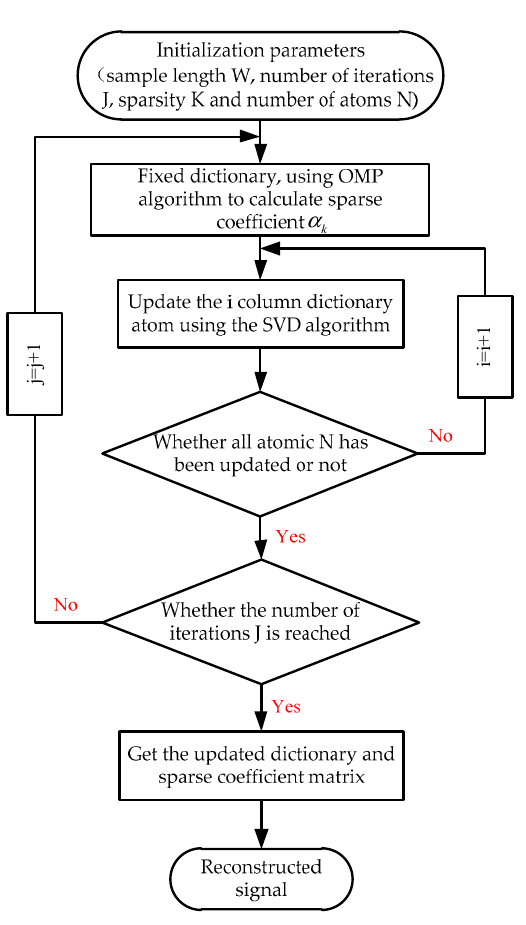
Figure 1. K-SVD algorithm flow.